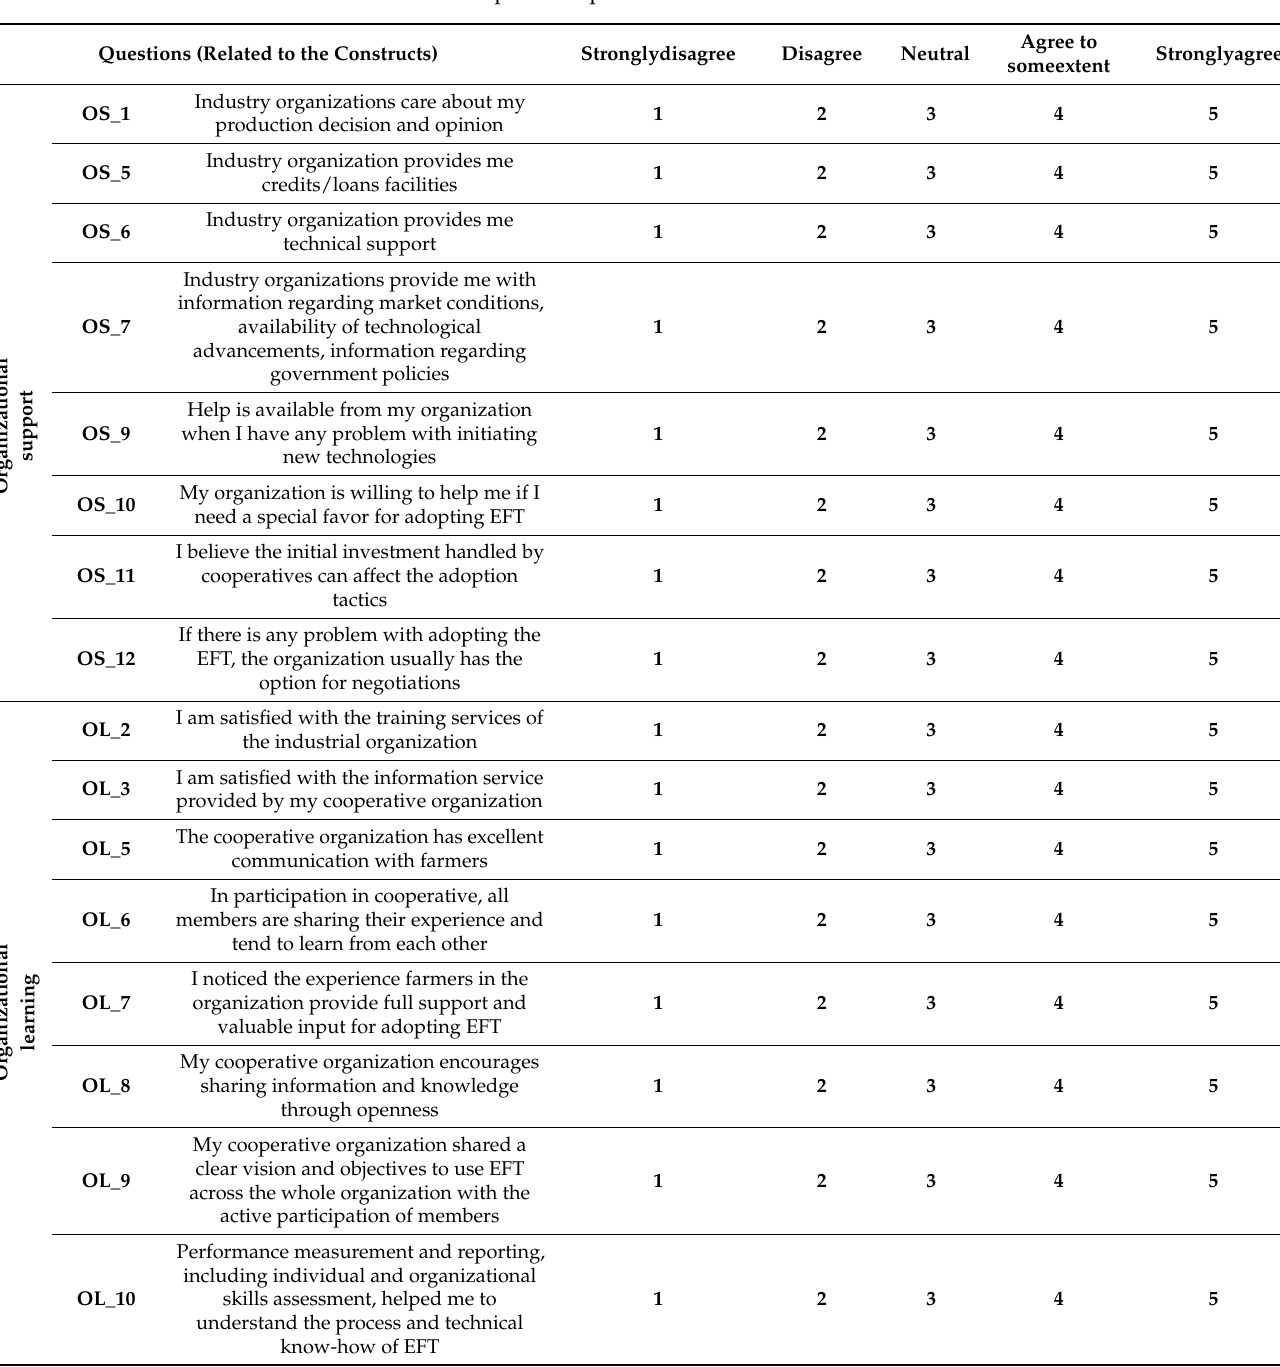
Table A1. Excerpt of the questionnaire used in the